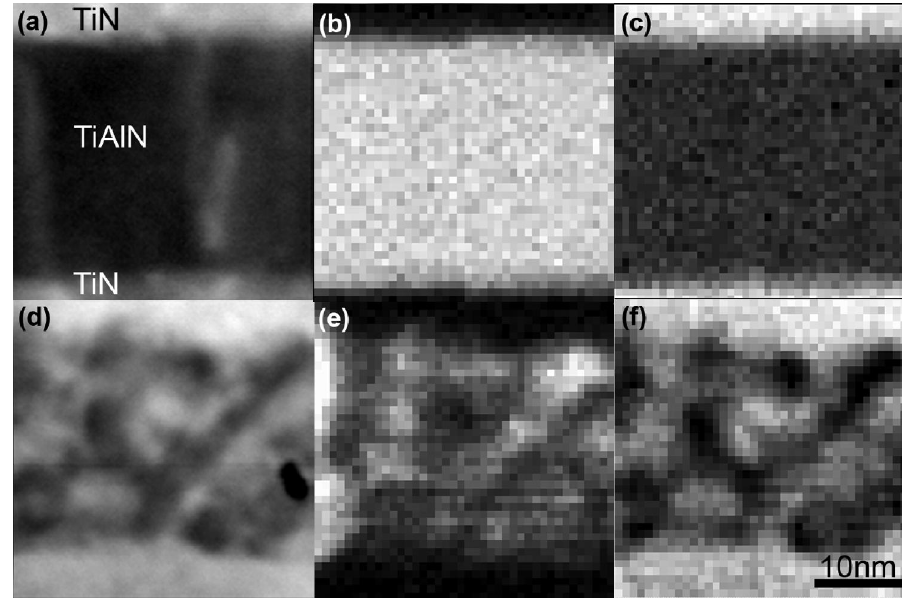
Figure 9. STEM images of as-deposited sample ( a ) and 900°C annealed sample ( d ) and corresponding Al and Ti STEM-EDX elemental maps in as deposited state ( b )–( c ) and annealed state ( e )–( f )